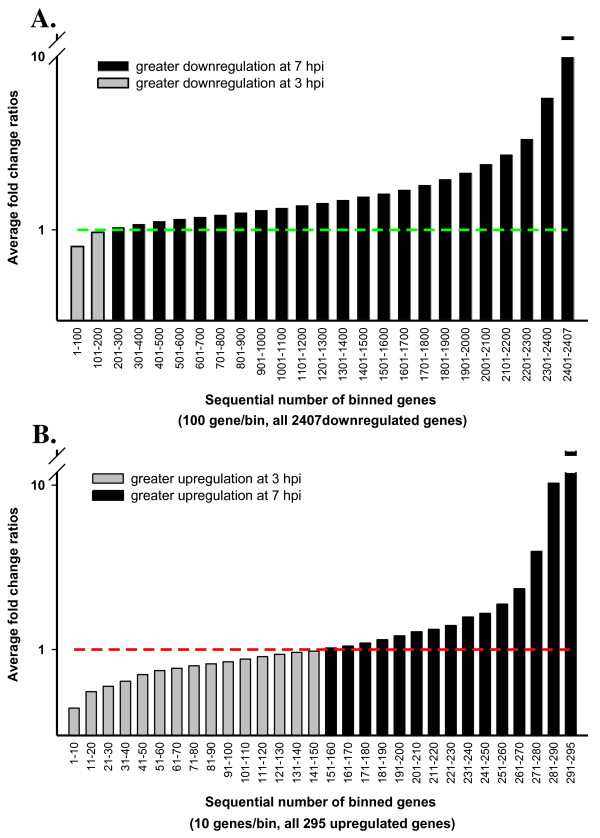
Up- and down-regulated transcripts follow different distribution patterns during infection progression. Each bar represents average fold-change ratios (FCRs) of gene expression at 7 hpi/3 hpi for either 100 consecutive downregulated genes (A), or 10 upregulated genes (B), after sorting all genes according to their FCR values from smallest to largest. Genes with average FCR values < 1 are in grey and those with values > 1 are in black. Results show most downregulated genes maintained an increasing suppression trend in the course of infection as more than 92% of the genes gave fold-change ratio > 1 (A). The 295 upregulated genes exhibited more balanced distribution between 7 and 3 hpi with about 51% of the genes having higher fold change at early time point.